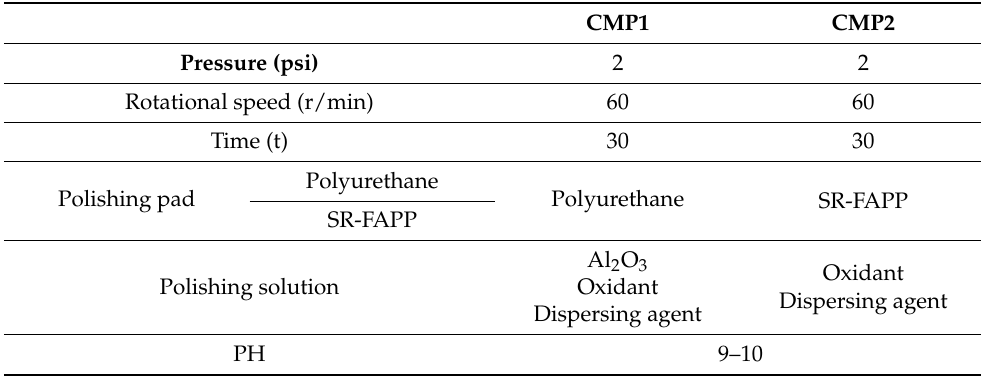
Table 2. CMP conditions of the 1SiC